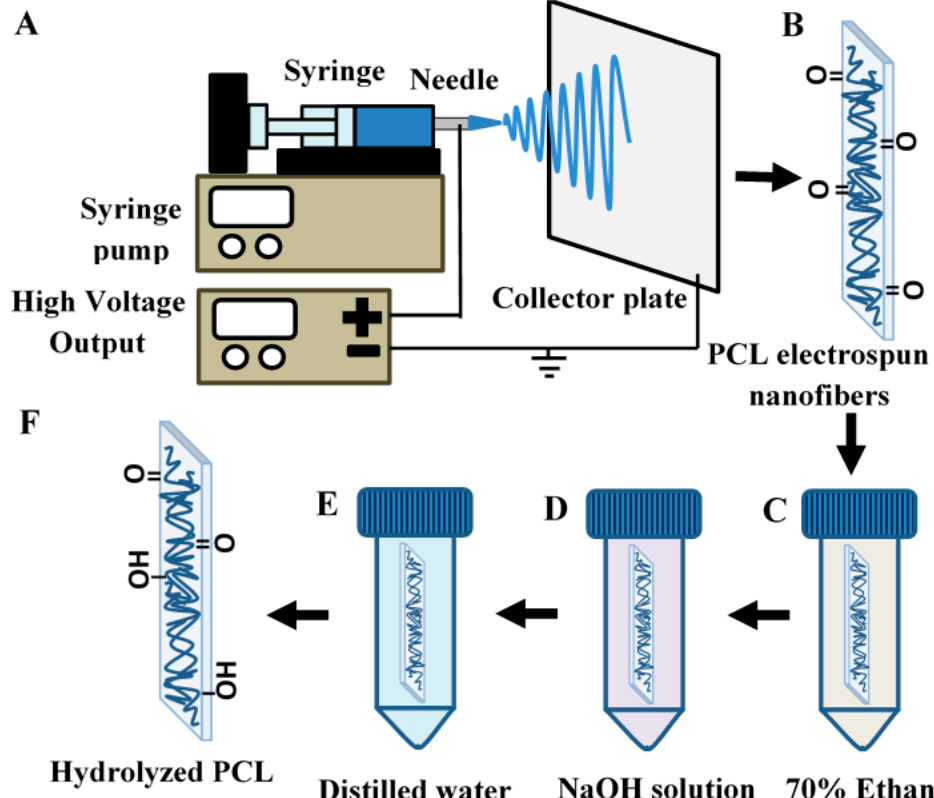
Figure 1. Schematic of electrospinning and alkaline hydrolysis of polycaprolactone (PCL).